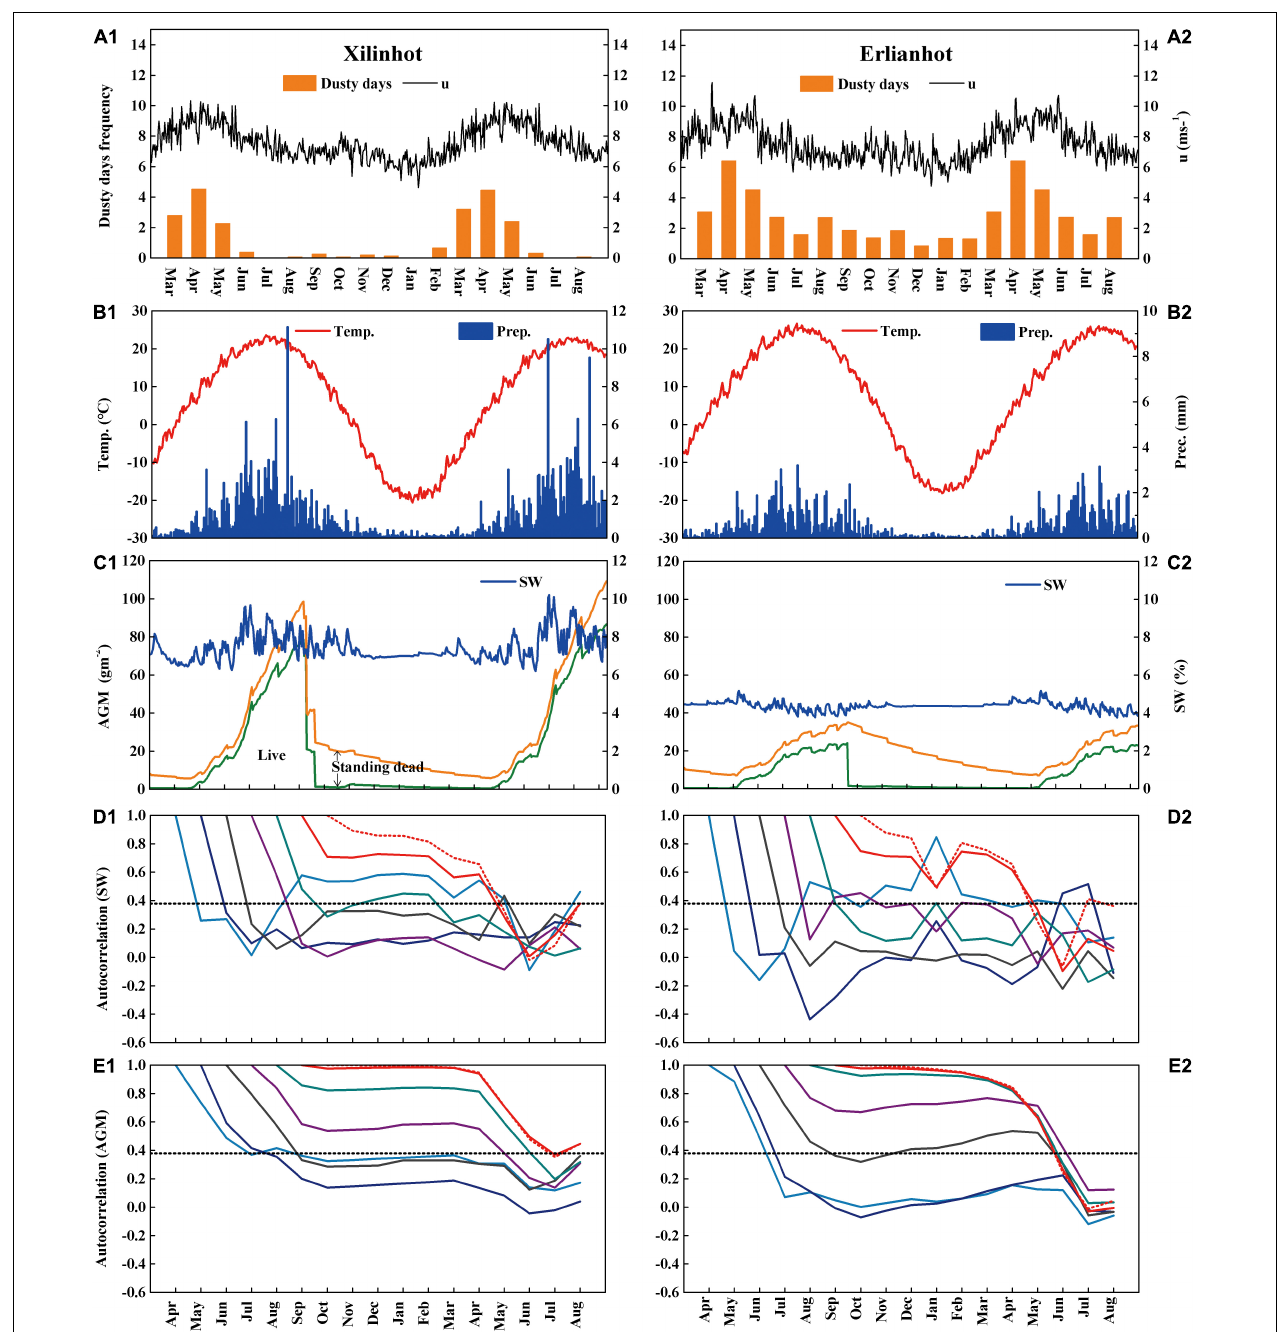
FIGURE 3 | Climatological (1981–2010) seasonal changes in (A) monthly dusty days, frequency and daily mean wind speed (u), (B) daily precipitation (Prec.) and air temperature (Temp.), (C) simulated SW in the 0–45 cm soil layer and aboveground mass (AGM) in the grazed area, and autocorrelations of (D) SW and (E) AGM. Horizontal dashed lines in (D,E) indicate the 5% significance